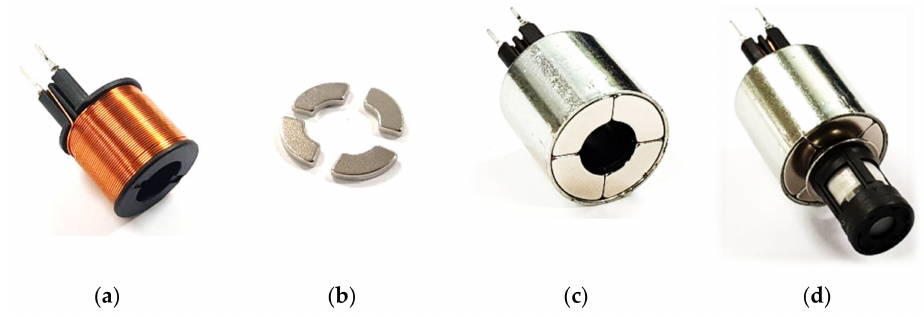
Figure 17. Manufacture of the permanent magnet TCV: ( a ) magnet coil winding; ( b ) permanent magnetic; ( c ) coil assembly; ( d ) TCV.